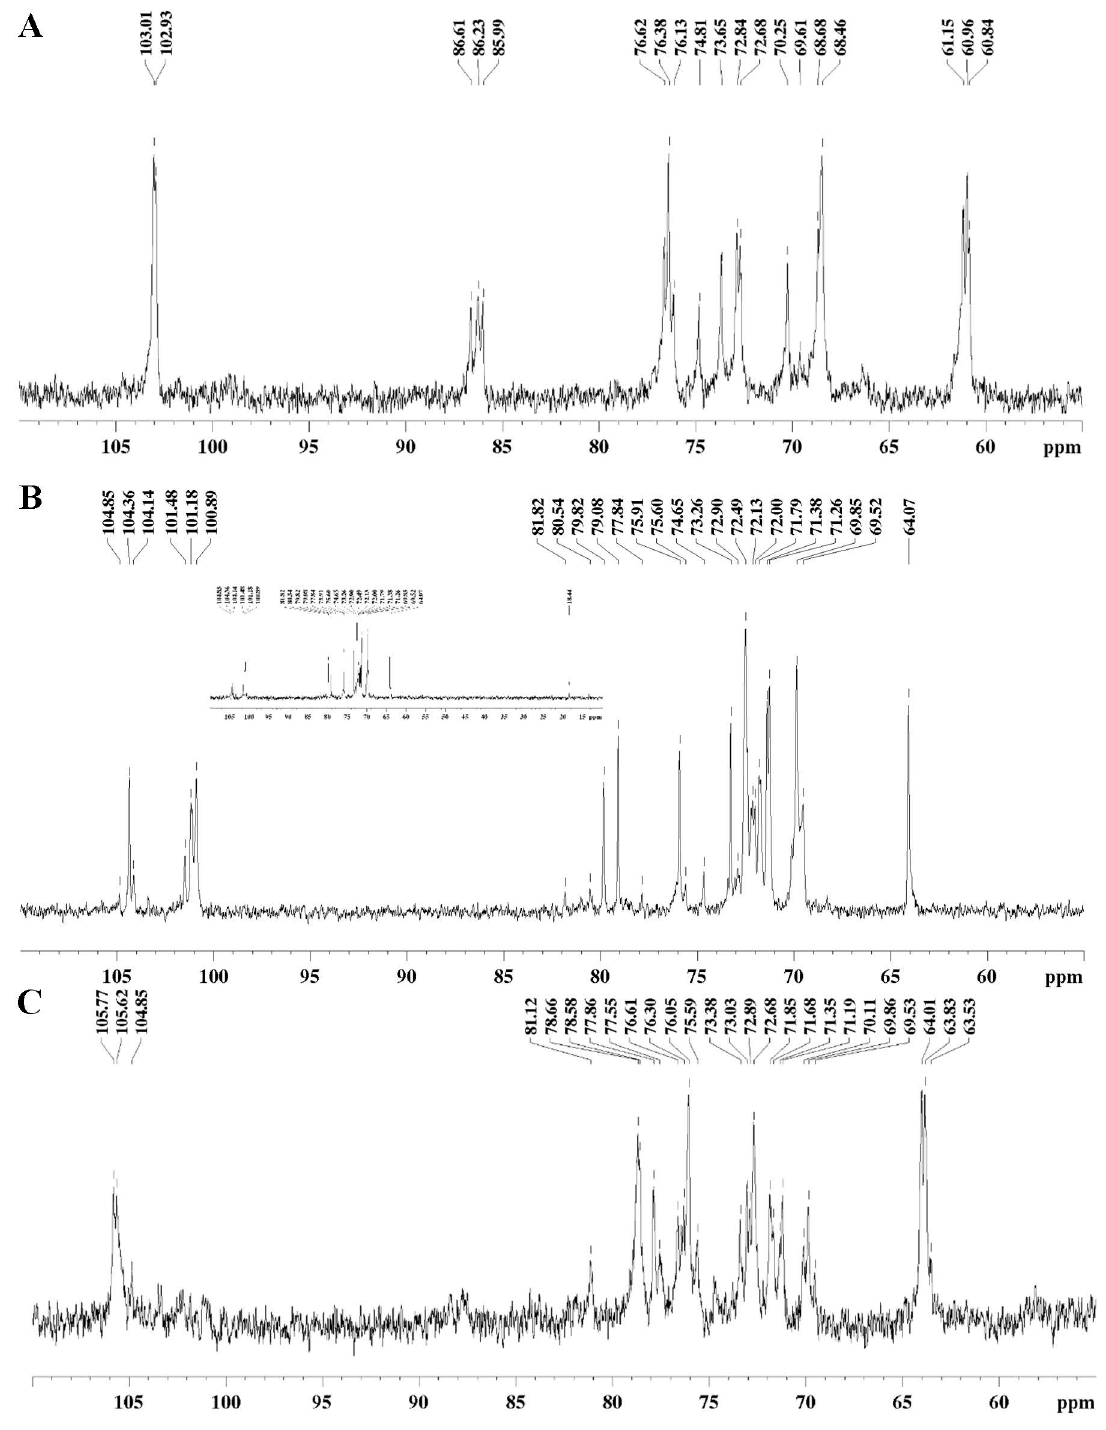
Figure 4. 13 C NMR spectra of the Gi -MRSW ( A ), Gi -FPME ( B ), and Gi -FSME ( C ) fractions obtained at 70 °C from the basidiomata of Gymnopilus imperialis